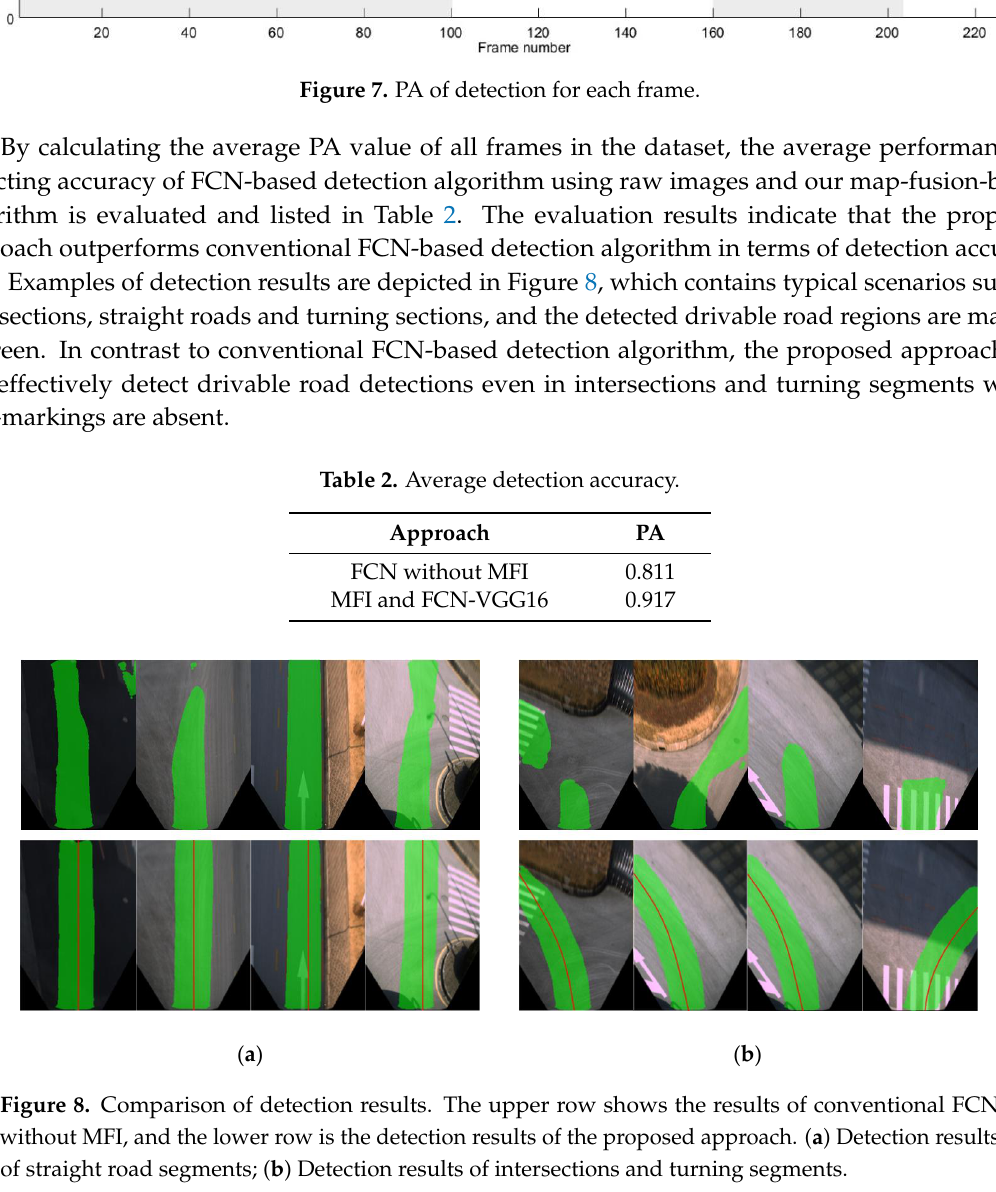
Figure 9. Robustness against illumination variation .